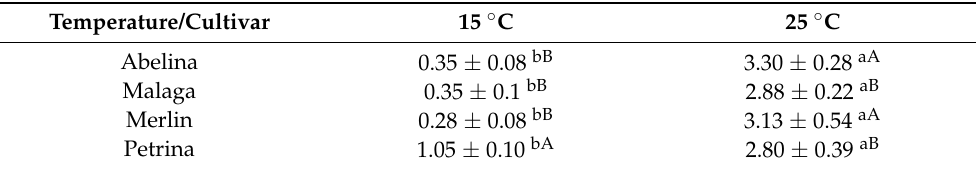
Table 2. Temperature effect on germination vigour index (Vi) of seeds of four soybean cultivars evaluated after 48 h.